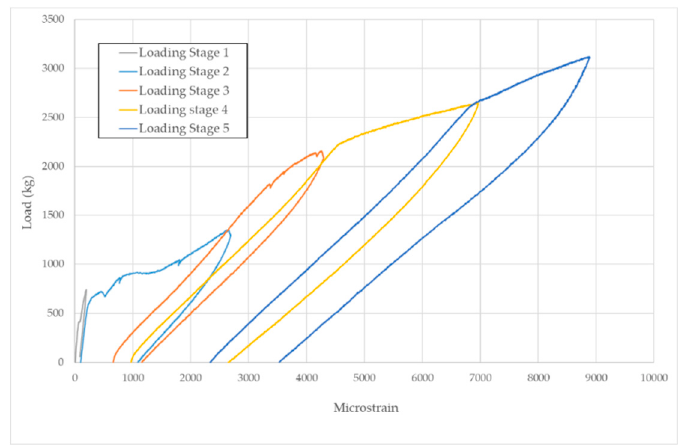
Figure 5. Loading–unloading curves for specimen A. Sensors 2019 , 19 , x FOR PEER REVIEW